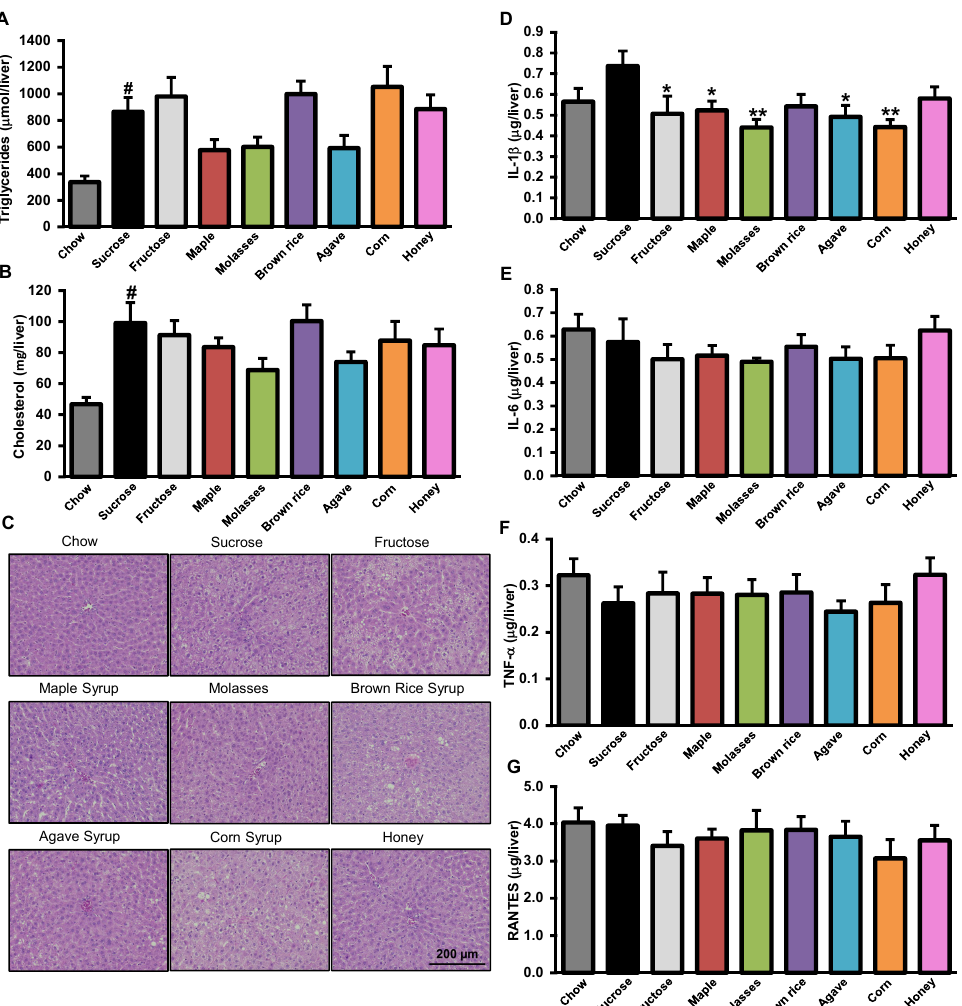
Figure 3. Natural sweeteners alleviated liver steatosis and inflammation. Liver steatosis, cholesterol content, and inflammation in male Wistar rats treated with refined sugars and natural sweeteners for 8 weeks. ( A ) Liver triglyceride TG content. ( B ) Liver cholesterol content. ( C ) Representative pictures of liver lipid droplets stained with H&E. ( D ) IL-1 β in liver. ( E ) IL-6 in liver. ( F ) TNF- α